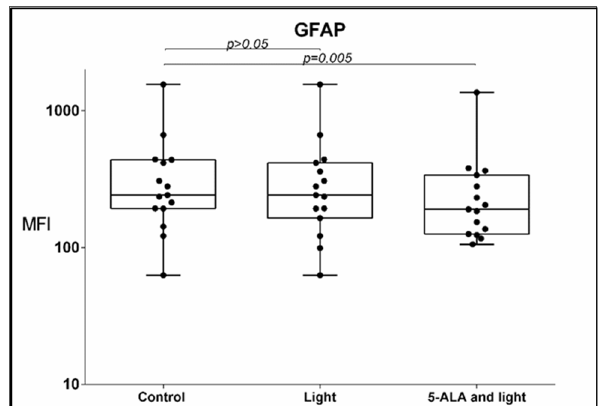
Figure 3. Boxplot showing the change in the percentage of GFAP-positive GB-MS С s across paired samples of control cell cultures, cell cultures treated with light only, and cell cultures exposed to 5-ALA and light. The GFAP expression was evaluated using multi-color flow cytometry, and every dot on the box plot represents the percentage values of all GFAP-positive GBM-MSCs in that par- ticular cell culture.